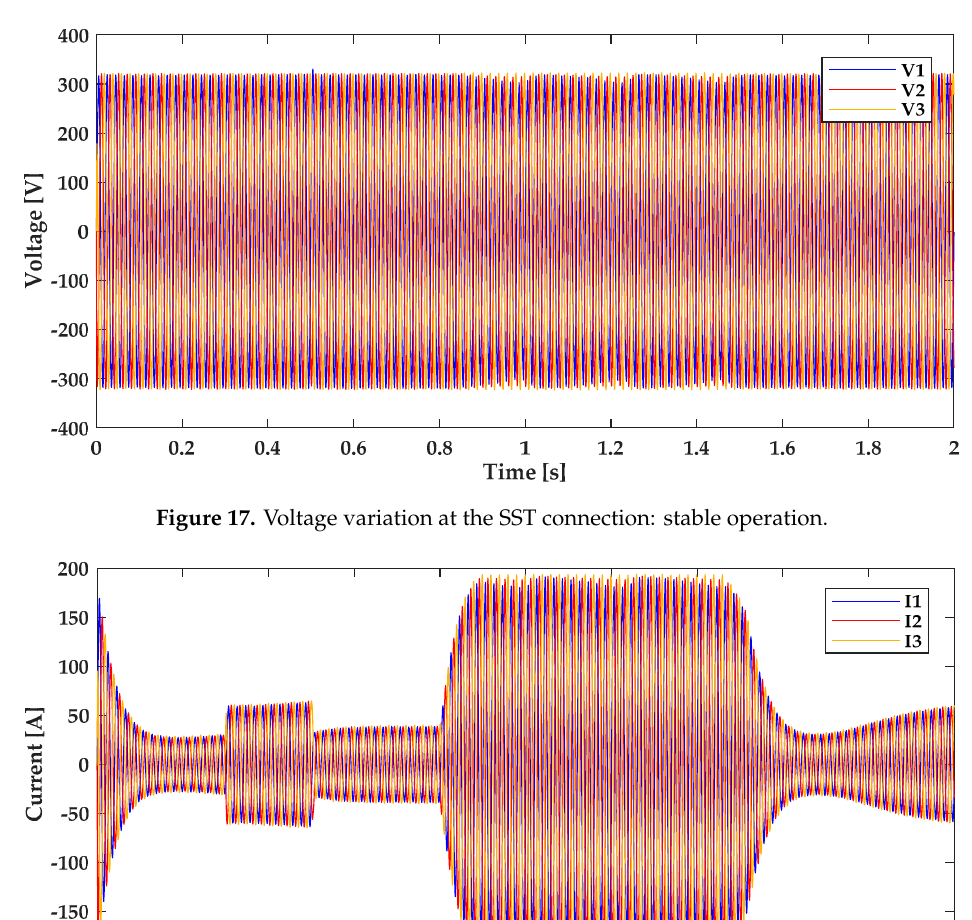
Figure 19. Voltage variation on SST AC connection in the unstable situation of “low inertia capacitor” of C DCbus = 10 mF (small value). V o lt a g e [ V ]